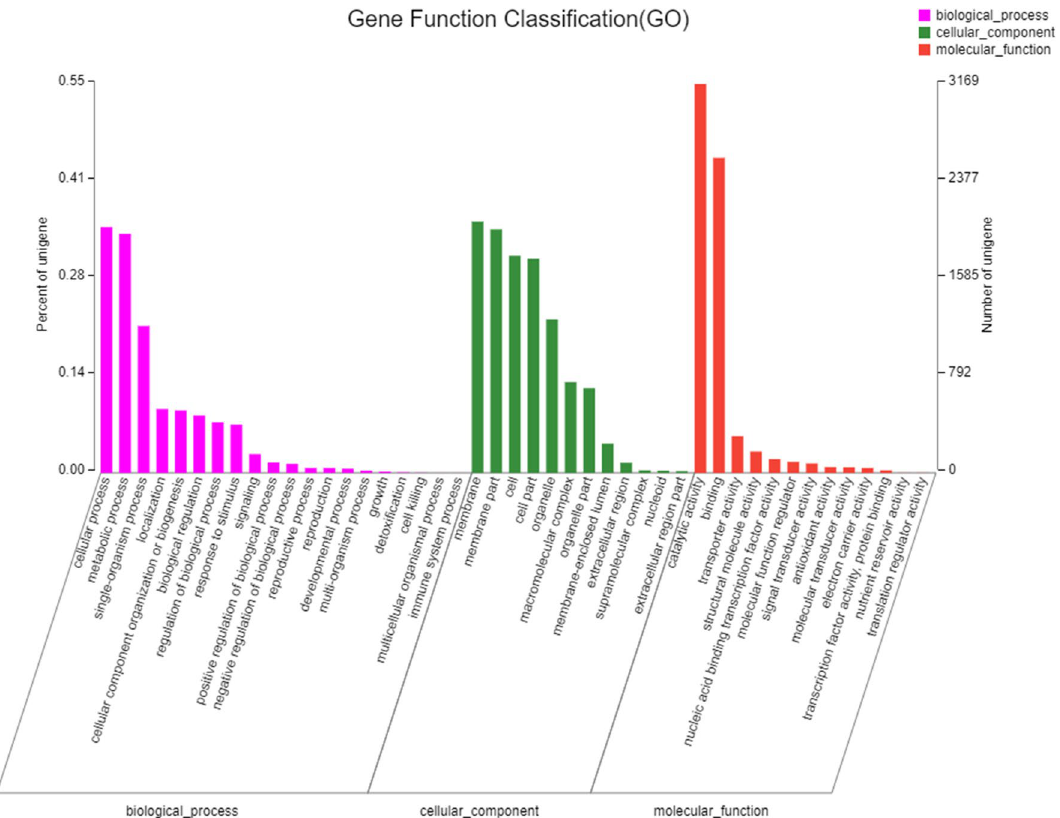
Figure 3. Gene ontology (GO) assignment of assembled unigenes of C. comatus . GO terms were processed by Blast2Go and categorized at the 2nd level under 3 main categories (biological process, cellular component, and molecular function).